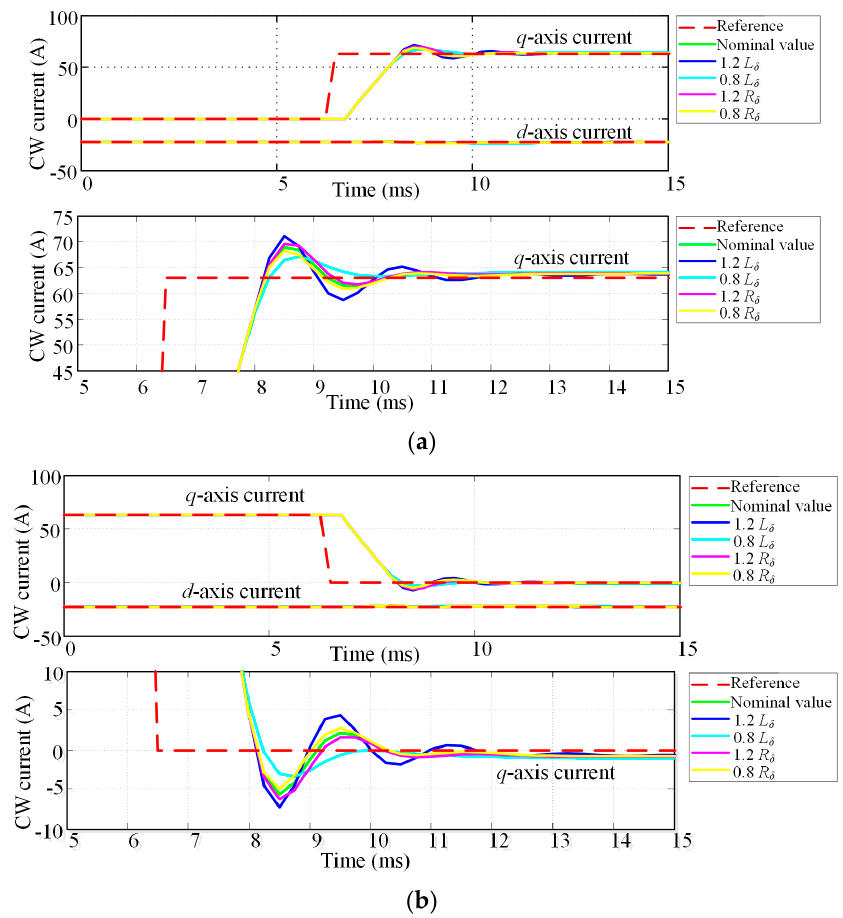
Figure 7. Dynamic responses of the CW currents with different estimated parameters at 750 rpm (measure (solid); reference (dashed)). ( a ) i cq changers from 0 A to 63 A; ( b ) i cq decreases from 63 A to 0 A.